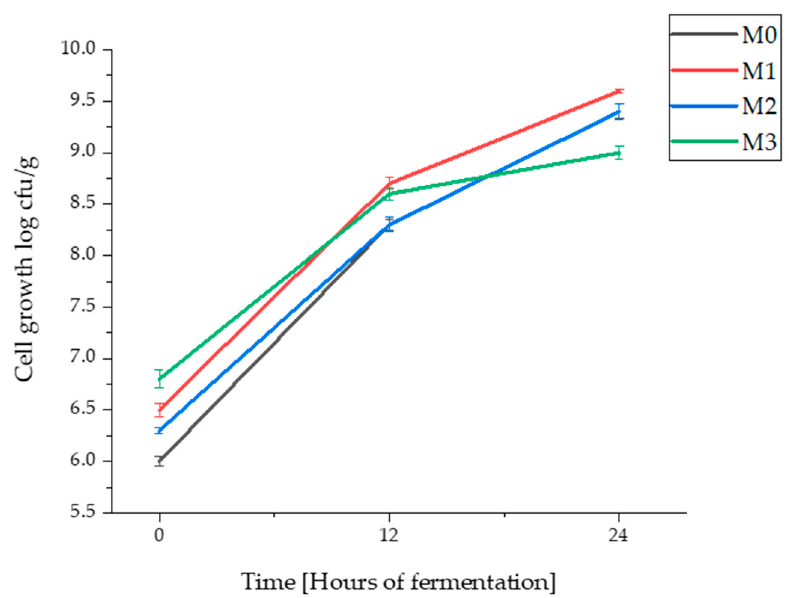
Figure 1. Cell growth in sourdough with wheat flour (M 0 ), einkorn flour (M 1 ), spelt flour (M 2 ), and emmer flour (M 3 ), fermented for 0, 12, and 24 h with Lactiplantibacillus plantarum ATCC 8014. Results are represented as mean values ± standard deviation (SD); n = 3.